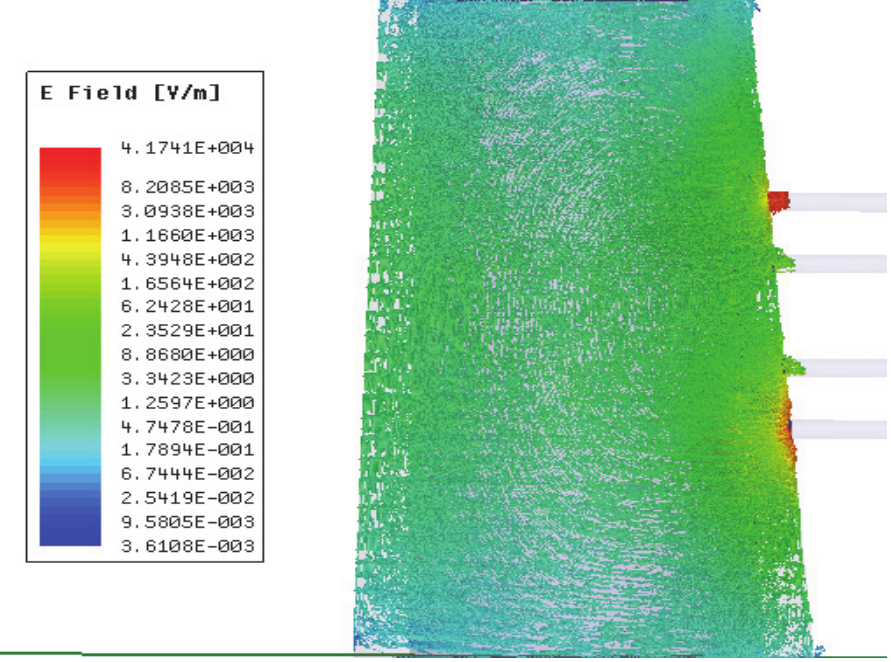
Fig.4 (b): Electric field distribution in the longitudinal view of the model simulated at 50 kHz for 2.3 mm arterial diameter. The magnitude has been indicated though different color